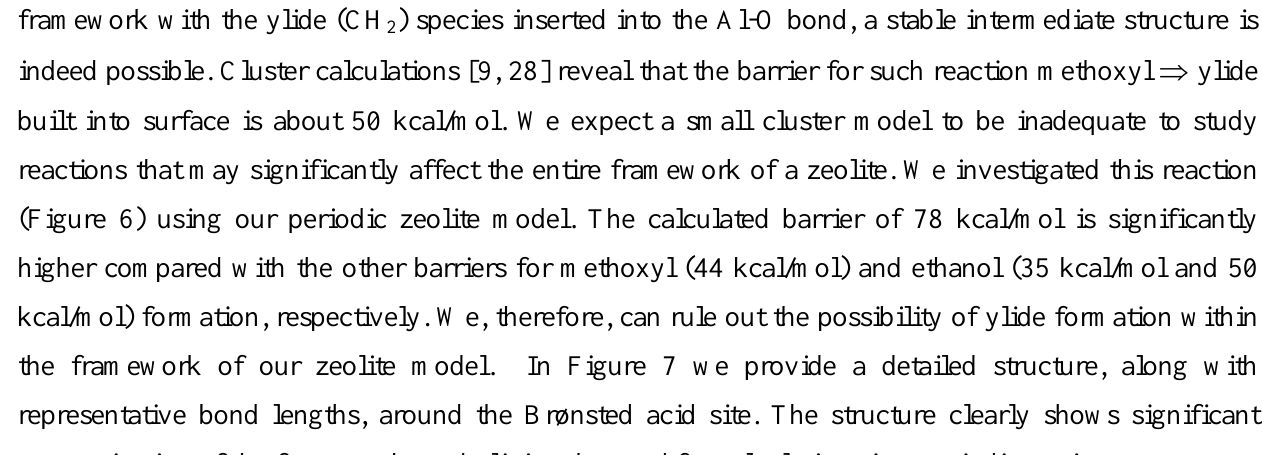
Figure 5. Formation of ethanol. Note that the water molecule is hydrogen bonded to the cage through the entire reaction and plays no visible role. This is a conventional S methoxyl species and the methanol molecule. (a) Surface methoxyl and methanol-water complex, (b) Transition state structure, (c) Ethanol molecule and proton transfer to Brønsted acid site. Dotted lines represent hydrogen